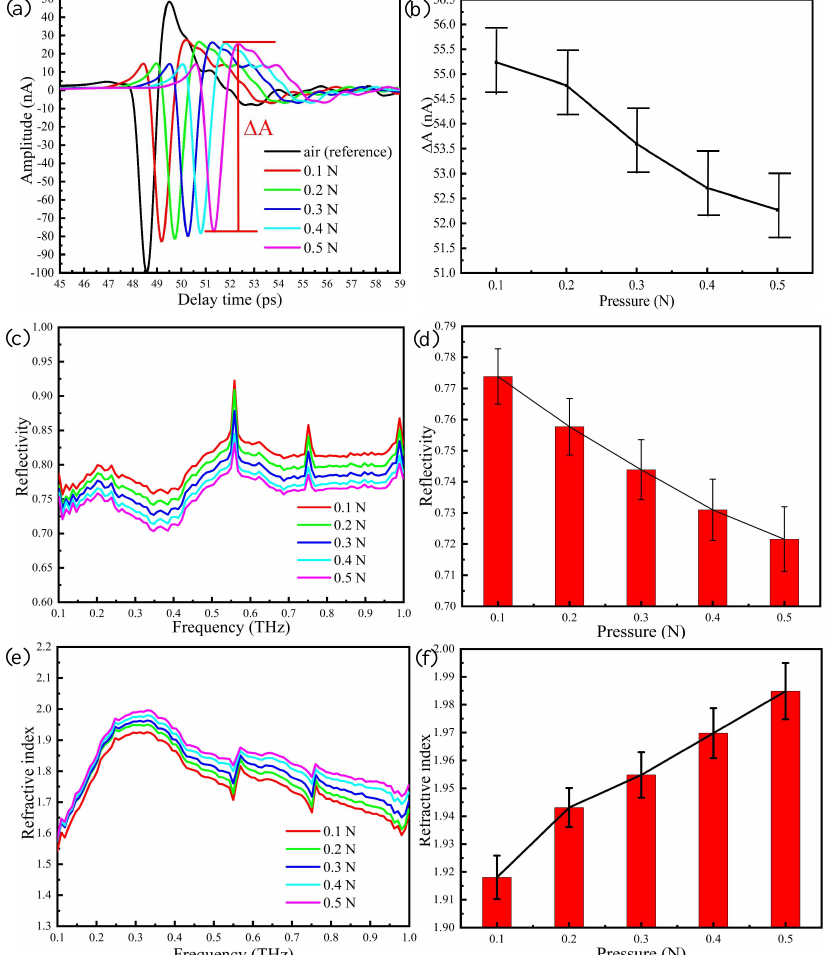
Figure 5. THz-ATR spectra obtained by placing the thumb on region 2 of the prism and with different pressures: ( a ) the time domain spectra, ( b ) the peak-to-peak amplitude, ( c ) the reflection spectra, ( d ) the error tree diagram of the reflectance at 0.3 THz, ( e ) the refractive index spectra, ( f ) the error tree diagram of the reflectance at 0.3